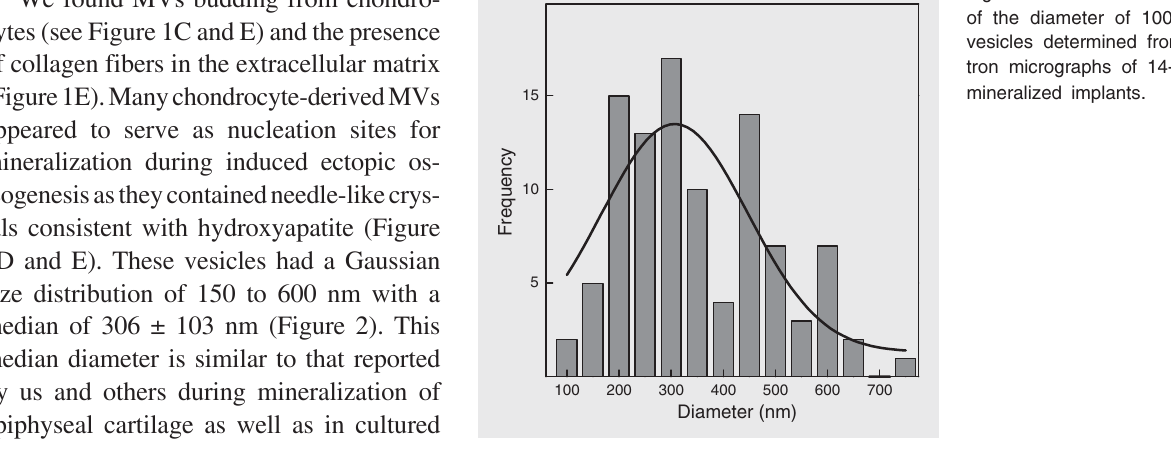
Figure 2 . Gaussian distribution of the diameter of 100 matrix vesicles determined from elec- tron micrographs of 14-day-old mineralized implants.